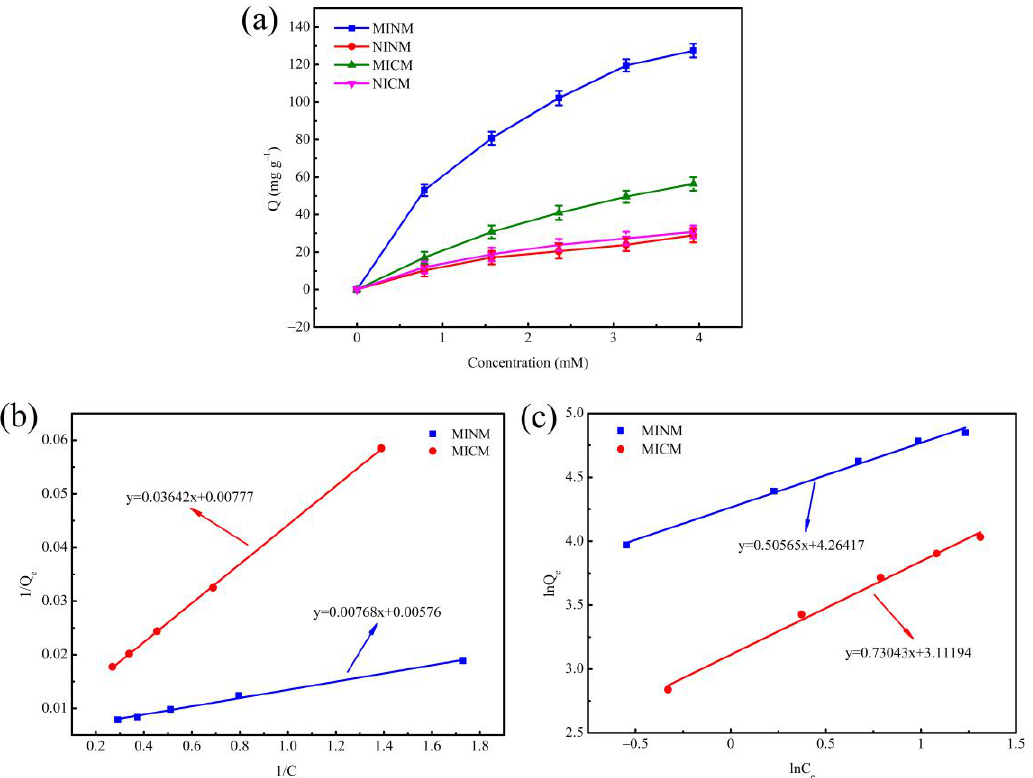
Figure 4. ( a ) The adsorption isotherms of MINM, NINM, MICM, and NICM; ( b ) the Langmuir iso-